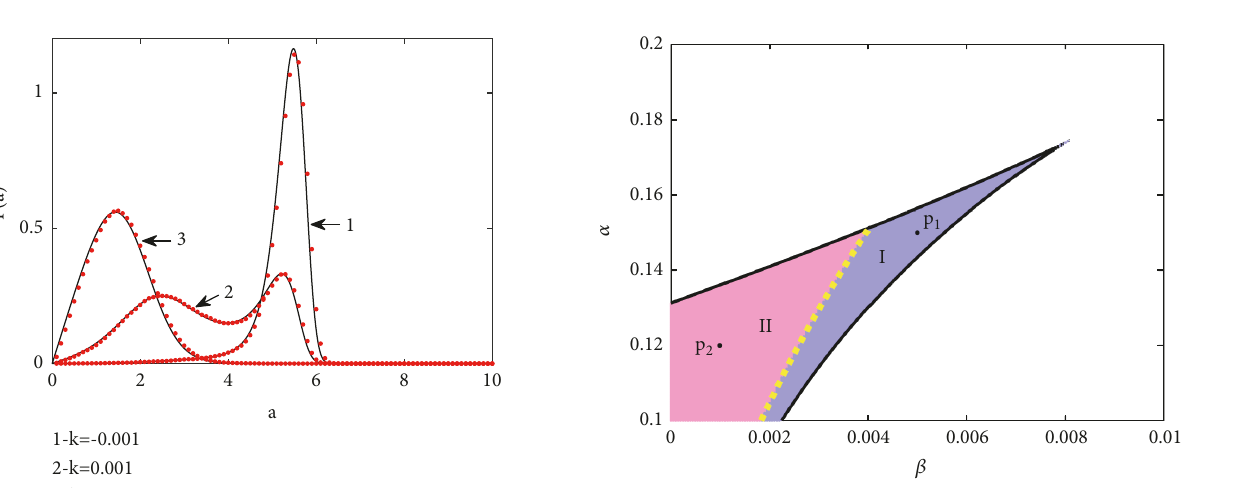
Figure 3: Parameter domain (𝛼, 𝛽) for the existence of the three limit cycles (area denoted by the colored area without the dotted line inabsenceofdelayedfeedback)andasinglelimitcycle(areadenoted by white region). The yellow dotted line denotes the bifurcation line characterizing the two parameter zones corresponding to the points 𝑝 1 (0.005,0.15) and 𝑝 2 (0.001,0.12) for two distinctdynamical scenarios in presence of delayed feedback corresponding to Figures 4(a) and 4(b),